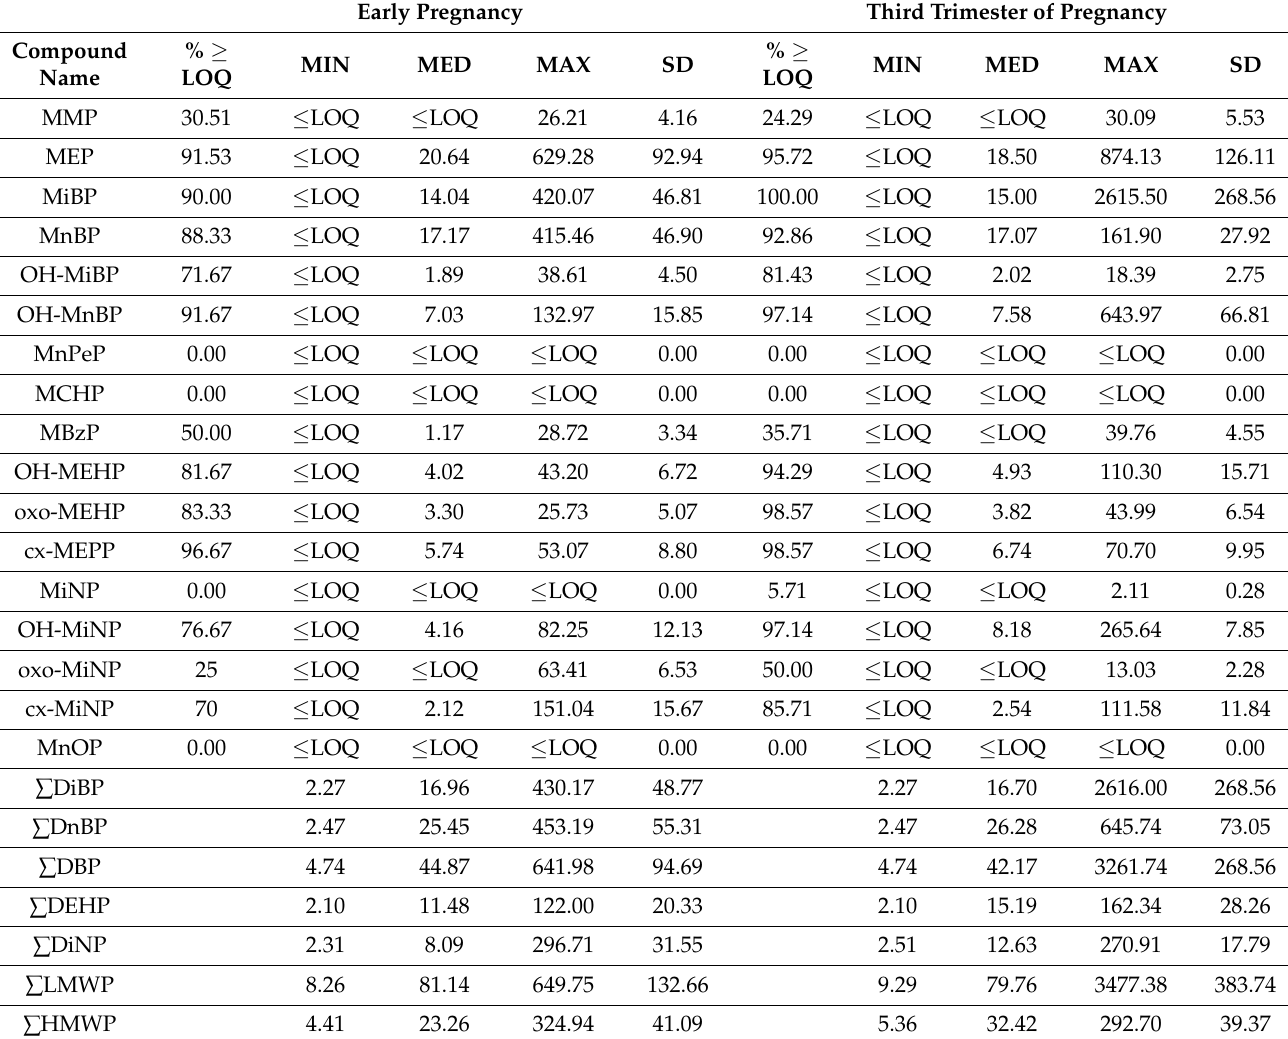
Table 4. Descriptive statistics of phthalate metabolite concentrations